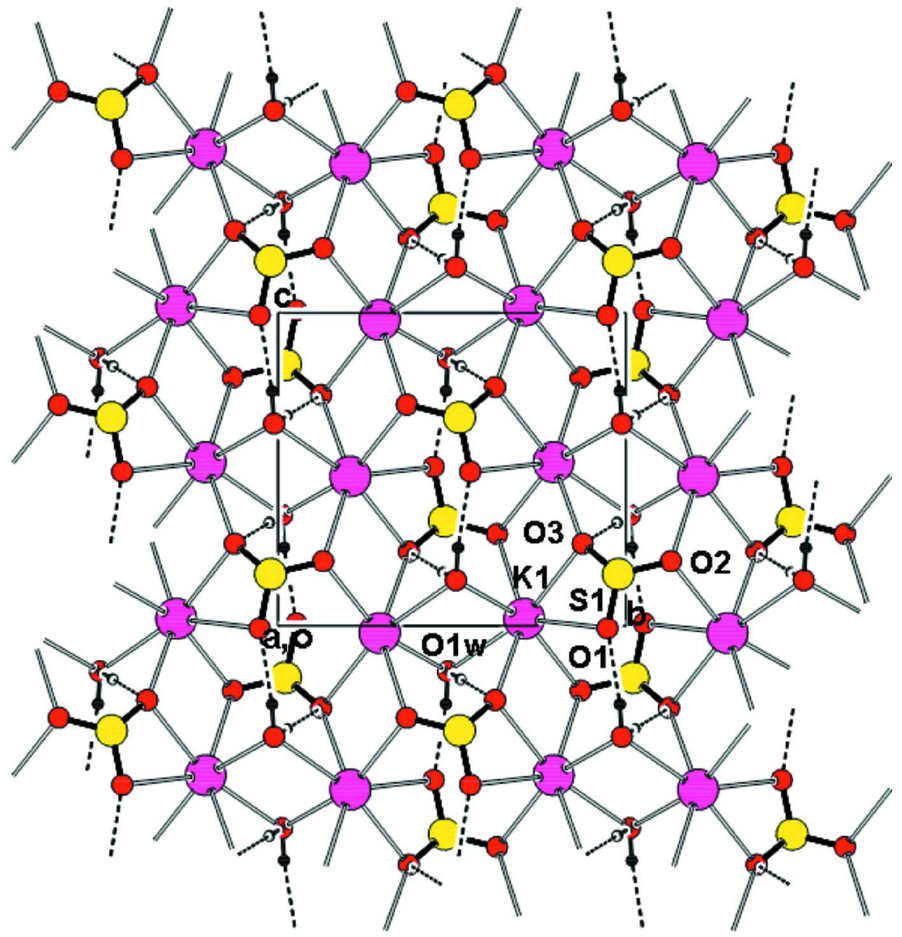
Figure 2 A view down the a axis of the formation of the two-dimensional sheet-like structure formed via the K···O contacts and the O—H···O hydrogen bonds [The hydrogen bonds are shown as dotted lines and the K···O contacts as open bonds. The iodobenzene moieties have been removed for